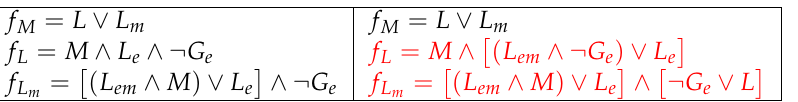
Figure 10. The reduced model ( left ) and the improved reduced model ( right ), where changes are marked in red.